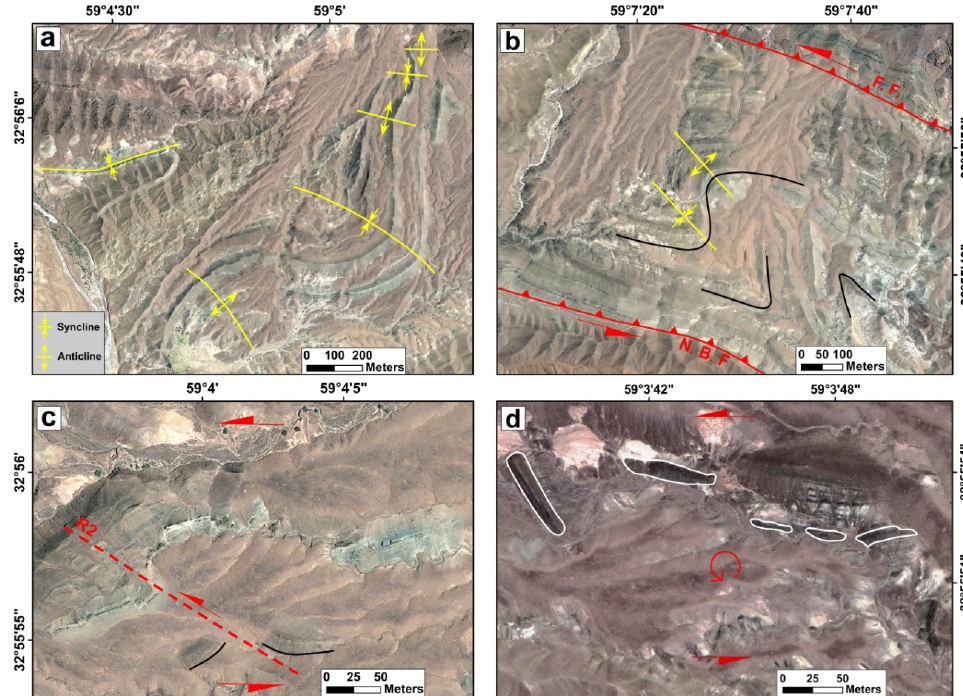
Figure 14. Satellite images (from Google Earth) of the folds in the Shekarab transpressional zone (see the locations on Figure 10a). ( a ) Sequences of anticlines and synclines with different axial traces. ( b ) Shear folds between the floor fault (Floor F.) and a segment of the North Birjand fault (N.B.F.). ( c ) The displacement of the rock units along the R2 and associate shear fold axial trace. ( d ) The boudinaged folds and counter-clockwise rotation of the